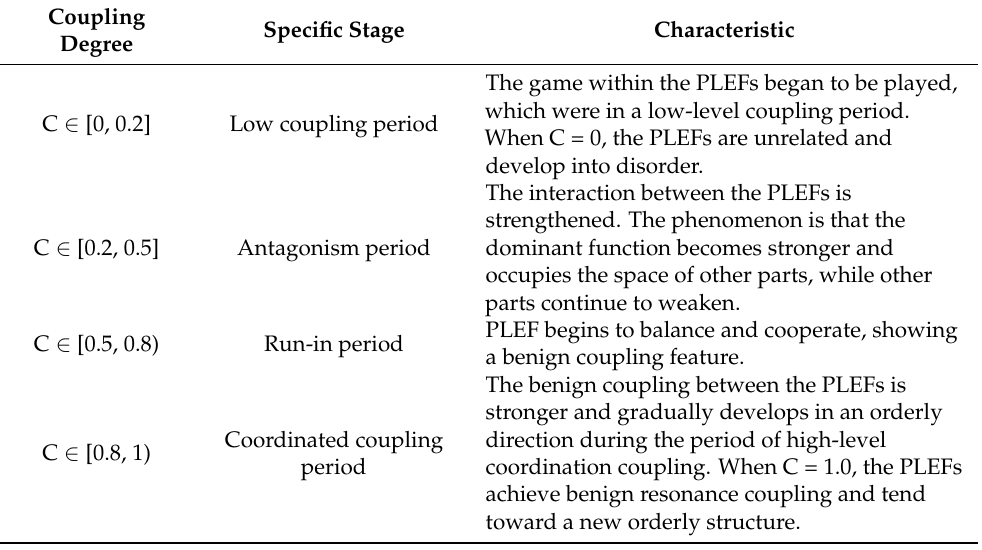
Table 2. Stage division of the coupling degree of